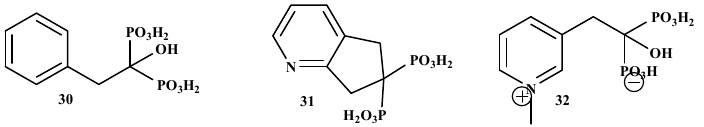
Figure 6. The structures of BP ‐ conjugates 30–32, risedronate containing compounds.